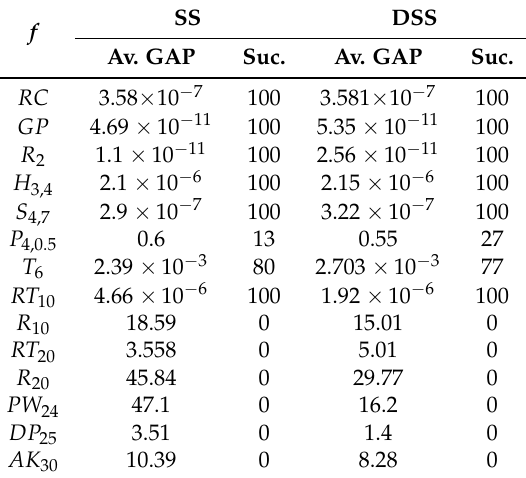
Table 6. DSS and SS results on Set